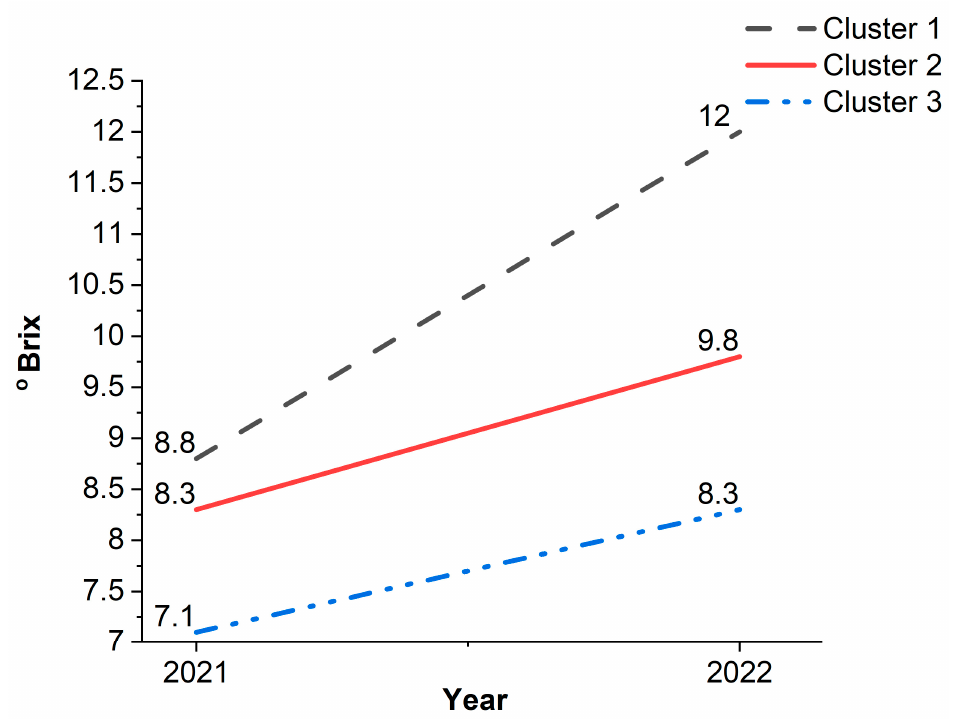
Figure 4. Grouping of strawberry cultivars by total soluble solids TSS (°Brix) content by the K-mean cluster analysis.